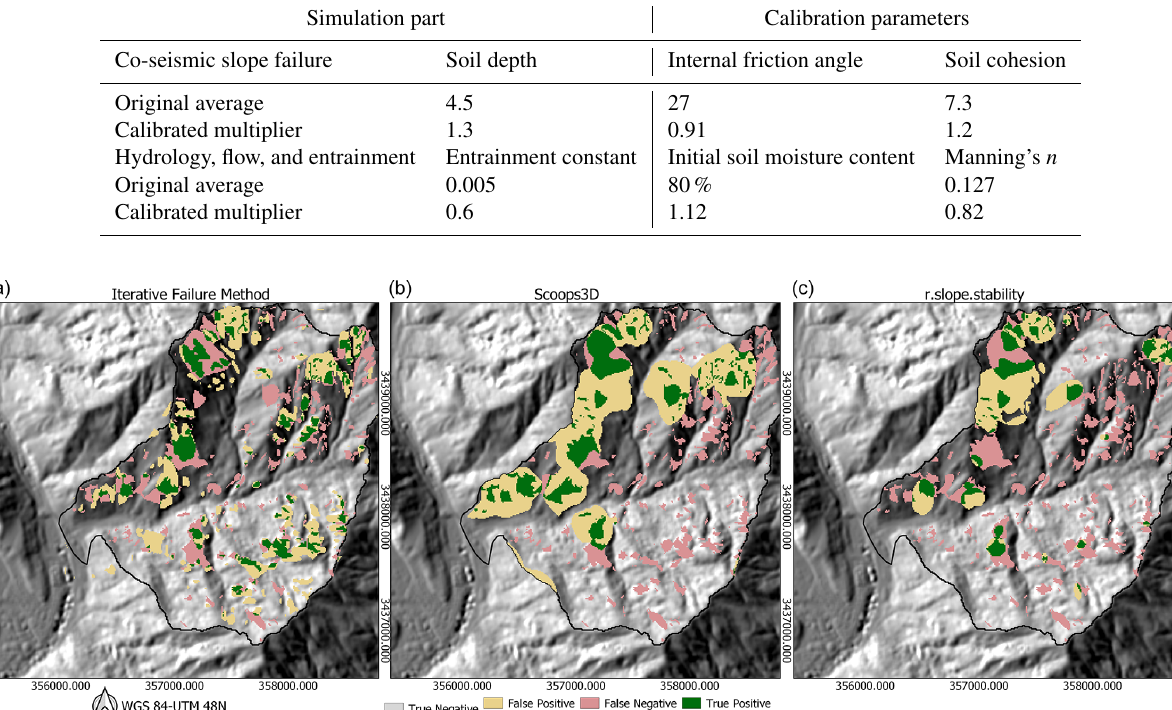
Figure 8. A comparison of simulated slope failure extent with mapped co-seismic slope failures. (a) OpenLISEM Hazard iterative failure with subsurface forcing, (b) Scoops3D random spheroid sampling, and (c) r.slope.stability random ellipsoid